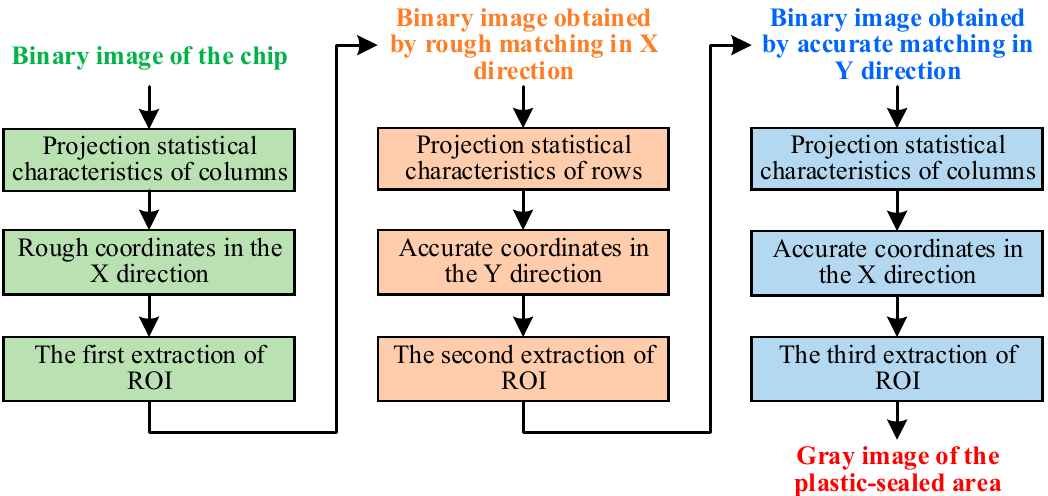
Figure 7. Flowchart of improved NCC template-matching algorithm for ROI extraction.